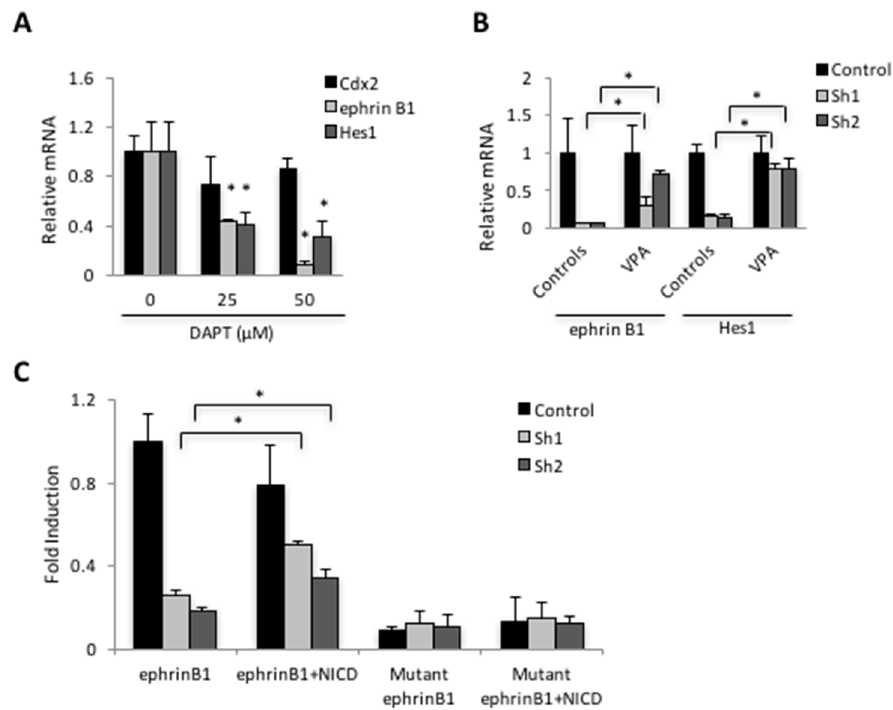
Figure 4. Notch signaling impacts the expression of EphrinB1 . RT-PCR from control and SW480 Cdx2 knockdown cells treated with the Notch inhibitor DAPT ( A ) or with the Notch activator VPA ( B ). ( C ) Relative expression of a wild type or RBPJ mutant EphrinB1 reporter in control and or Cdx2 knockdown SW480 cells with or without an NICD expression vector. Error bars represent the standard deviation from three independent samples. * p < 0.05 relative to control by Student’s t -test.